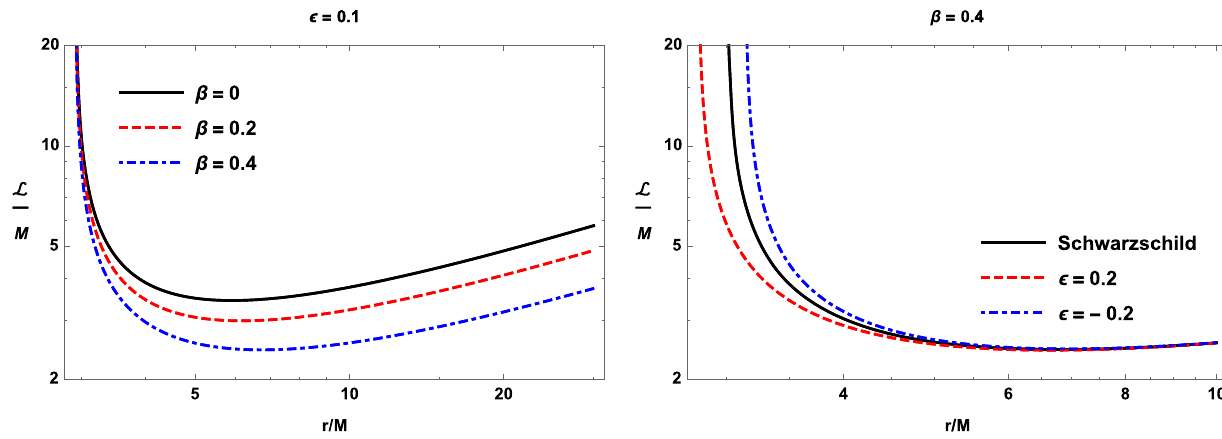
Fig. 7 Radial dependence of the angular momentum of a magnetic dipole for the different values of the magnetic parameter β (left panel) and deviation (cid:2) (right panel)